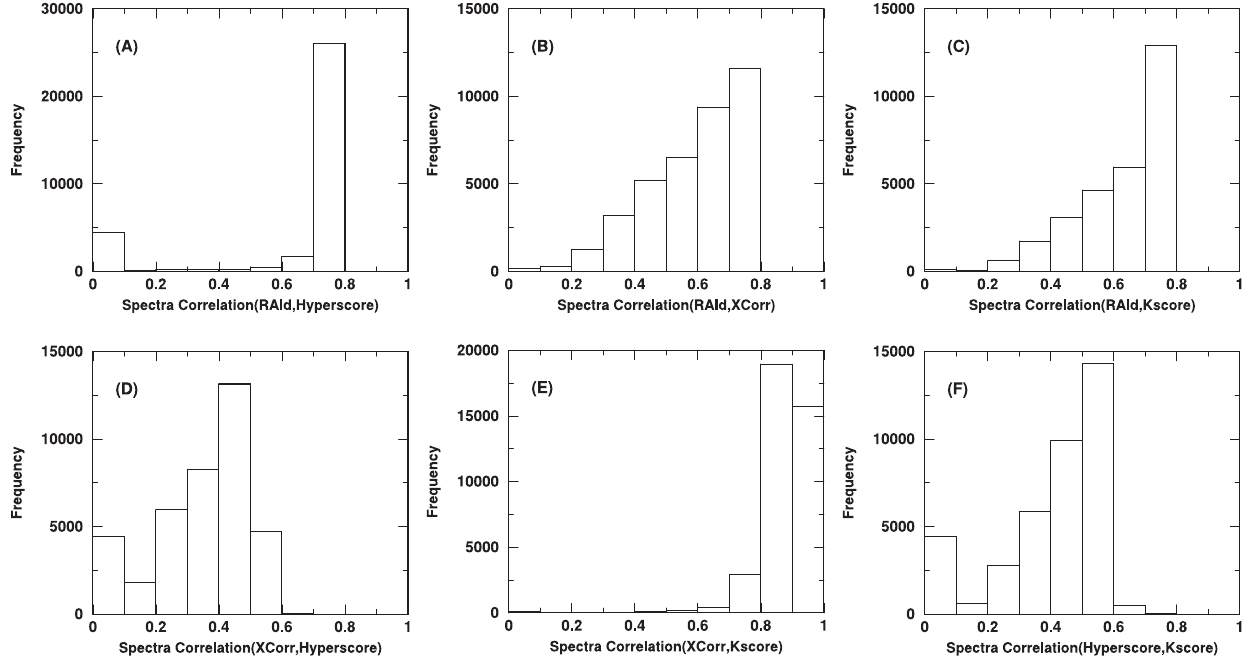
Figure 3. Histograms of correlations between filtering strategies. Used in this plot are 38,424 raw centroid spectra from the ISB data set [28]. Each raw spectrum will have four different processed spectra come from each of the four different filtering strategies. The mass fragments of every filtered spectrum are then read to a mass grid. The spectrum is then viewed as a vector with non-vanishing components only at the populated component/mass indices. One then normalizes each filtered spectrum vector to unit length. An inner product of any two filtered spectral vectors represents the correlation between them. When the spectral quality does not pass a method-dependent threshold, the corresponding filtering protocol may turn the raw spectrum into a null spectrum without further searching the database. For a given pair of filtering methods and a raw spectrum, if each of the two filtering methods produces a nonempty filtered spectrum, one may turn those filtered spectra into spectral vectors and compute their inner product, i.e., their correlation. For each pair of filtering methods, these inner products are accumulated and plotted as a correlation histogram. All six pairwise combinations are shown. doi:10.1371/journal.pone.0015438.g003 PLoS ONE |